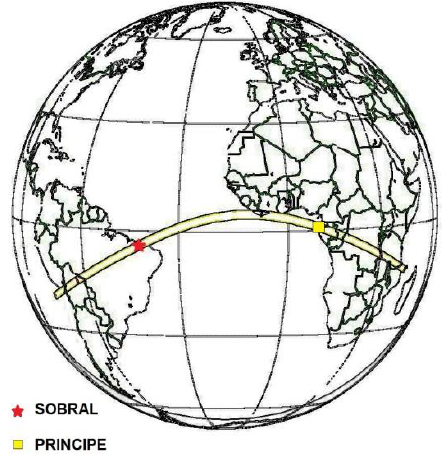
Figure 2. Path of the total solar eclipse of 29 May 1919. Locations of Sobral and Principe are shown.